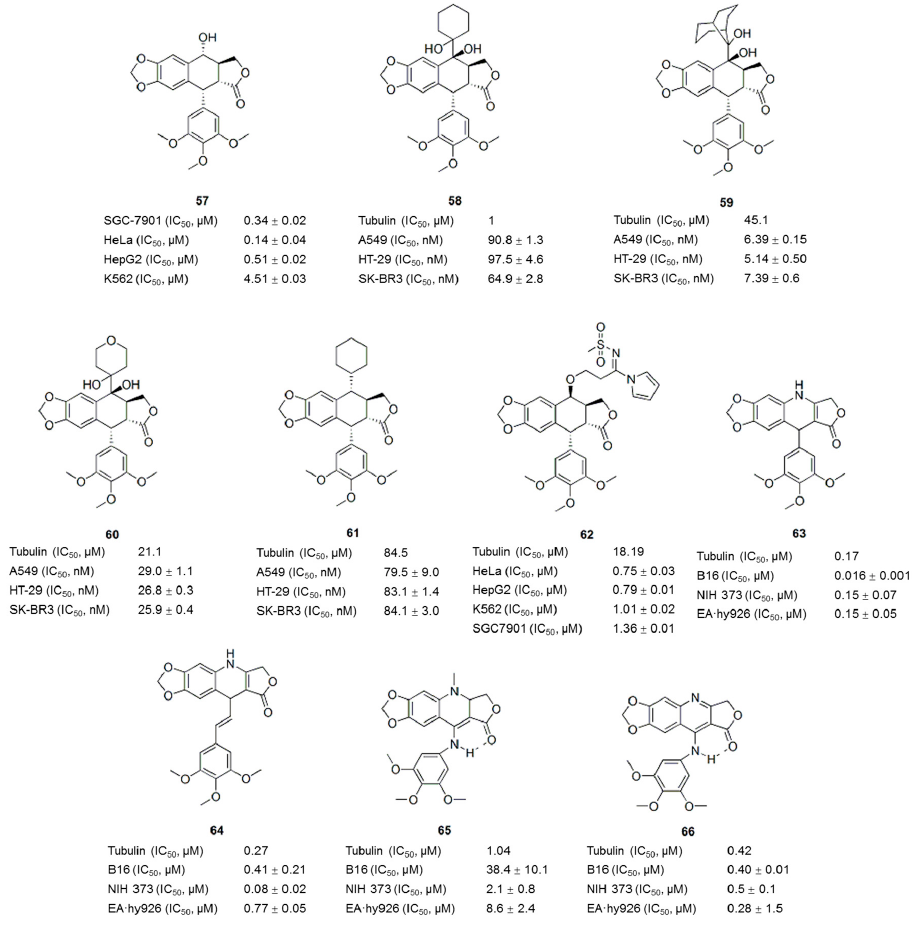
Figure 8. Podophyllotoxin and its derivatives/analogues.